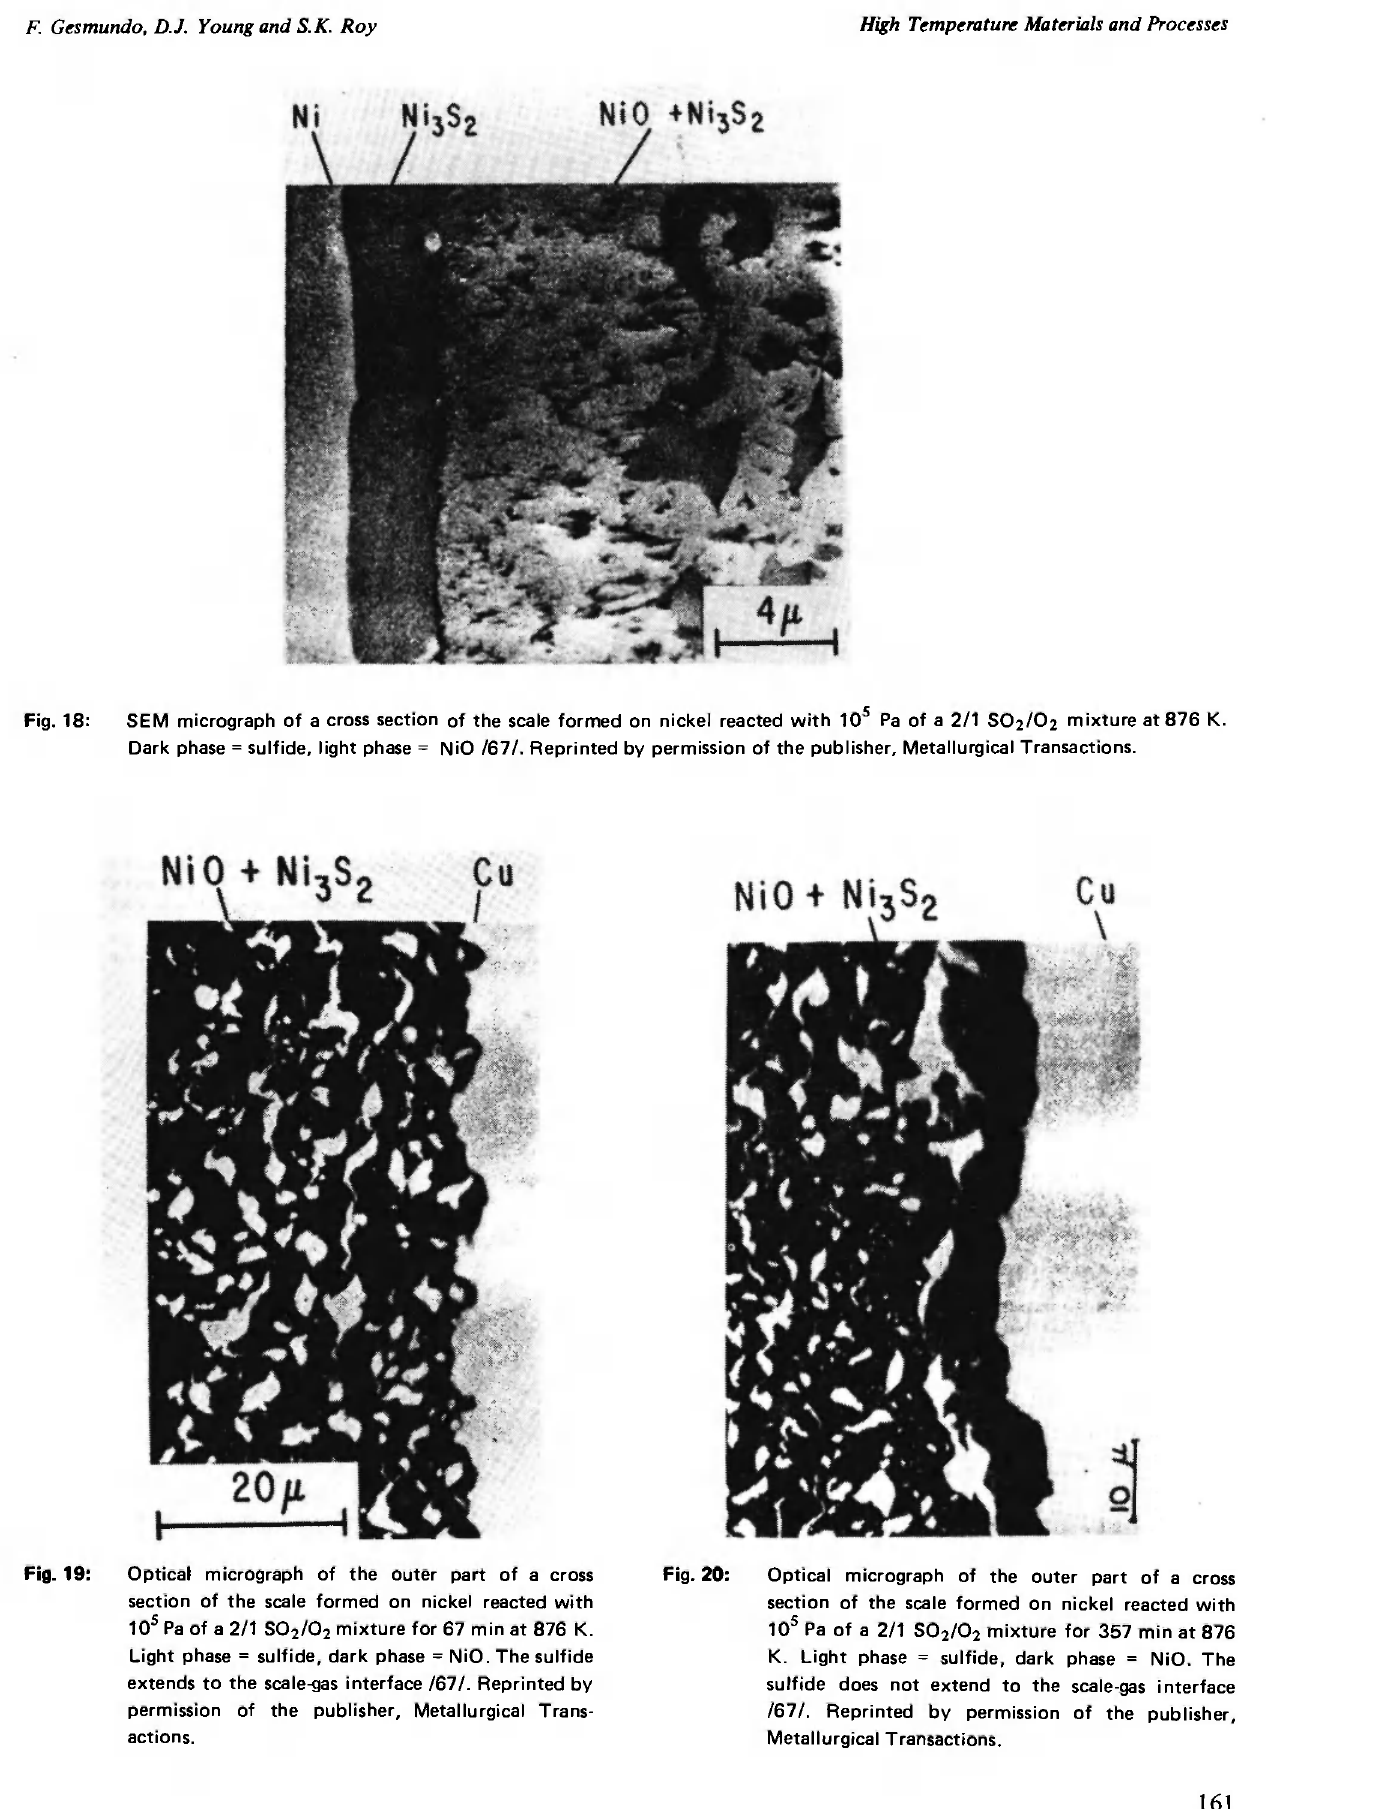
Fig. 19: Optical micrograph of the outer part of a cross section of the scale formed on nickel reacted with 10 5 Pa of a 2/1 S0 2 /0 2 mixture for 67 min at 876 K. Light phase = sulfide, dark phase = NiO. The sulfide extends to the scale-gas interface /67/. Reprinted by permission of the publisher. Metallurgical Trans- actions.